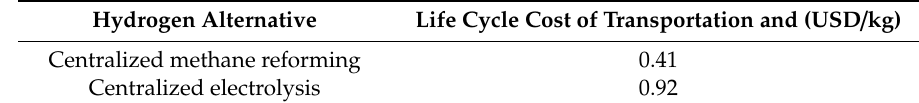
Table 5. Life Cycle Costs of Hydrogen Transportation.